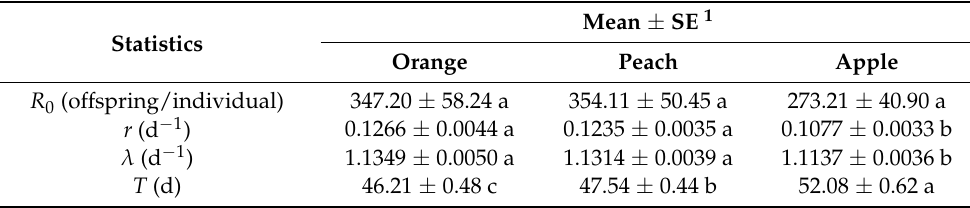
Table 3. Means and standard errors of the net reproductive rate ( R 0 ), intrinsic rate of increase ( r ), finite rate of increase ( λ ), and mean generation time ( T ) of Bactrocera dorsalis on three host fruits.